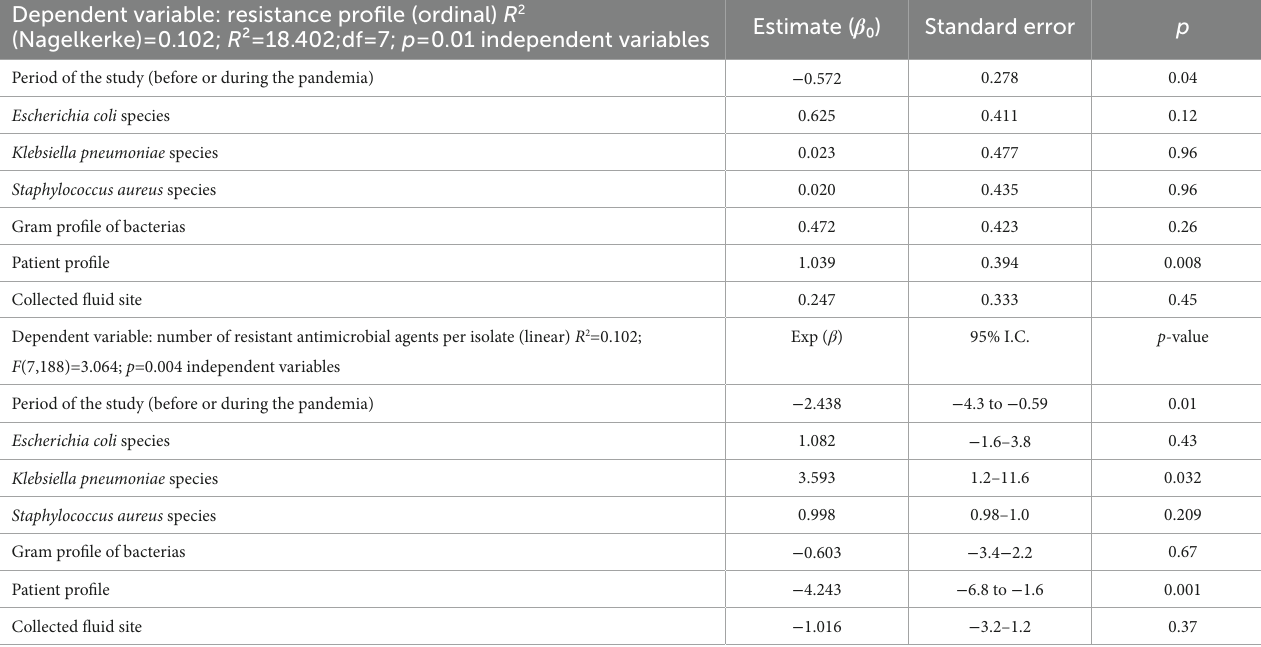
TABLE 2 Results of the multiple ordinal regression and multivariate linear regression analysis about antimicrobial resistant and multi-resistant drugs. Dependent variable: resistance profile (ordinal) R 2 (Nagelkerke)=0.102; R ²=18.402;df=7; p =0.01 independent variables